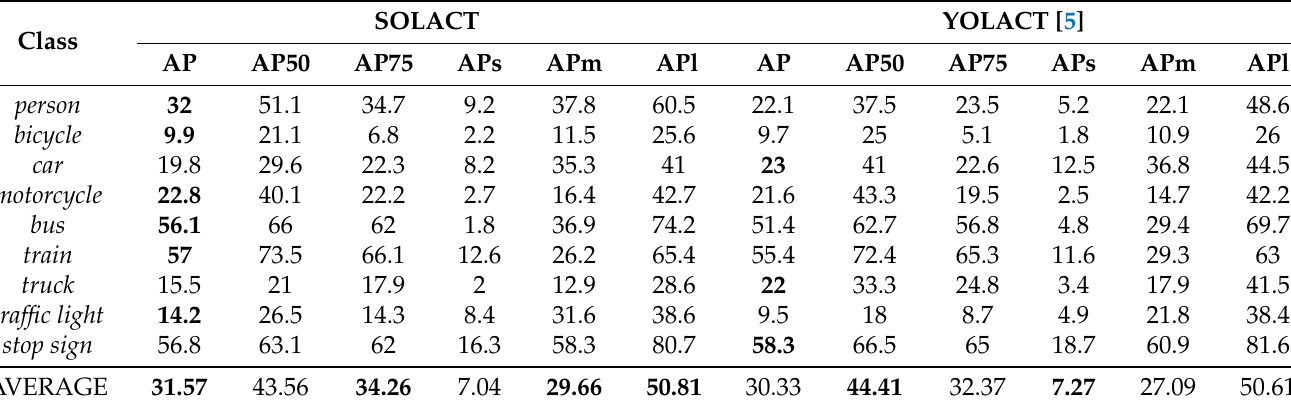
Table 2. Instance segmentation results over the COCO test set [31] using COCO metrics ( ↑ ). APs, Average Precision, small areas; APm, AP, medium areas; APl, AP, large areas.